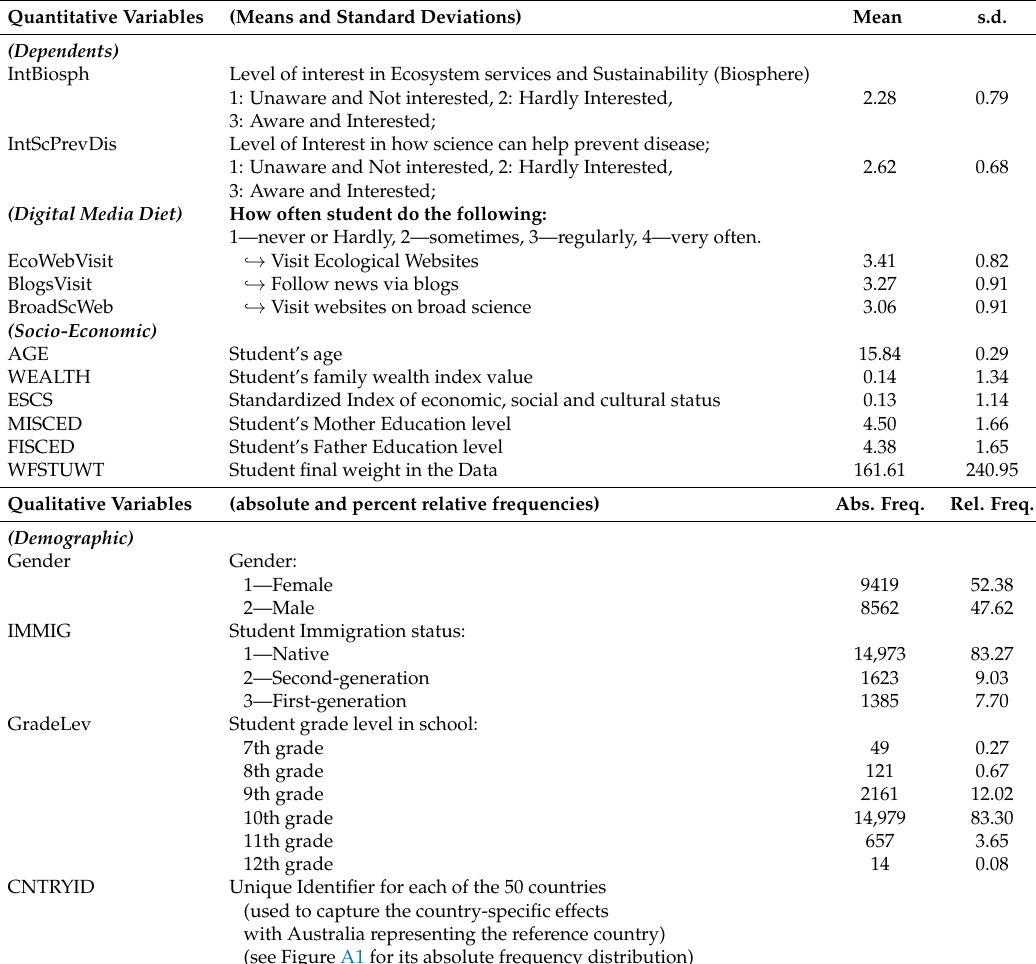
Table A1. Summary Description of the Variables used in the Econometric Modeling. (N = 187,821). Quantitative Variables (Means and Standard Deviations) Mean s.d. Level of interest in Ecosystem services and Sustainability (Biosphere) 1: Unaware and Not interested, 2: Hardly Interested, 2.28